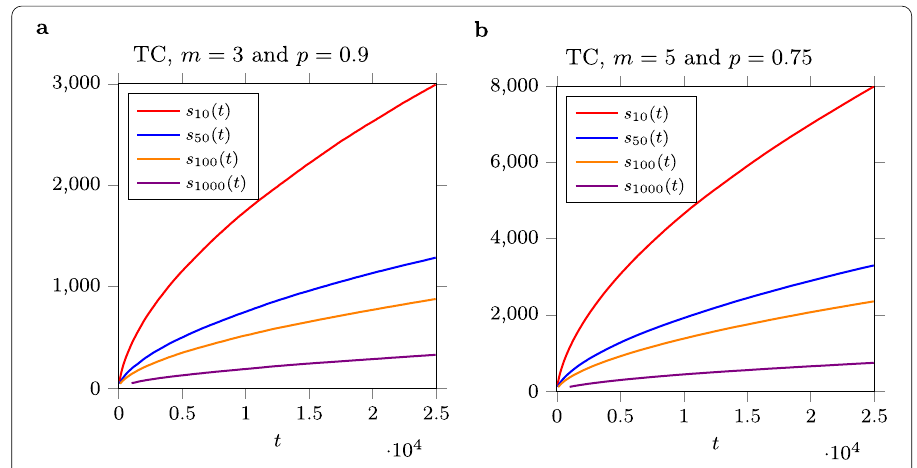
Fig. 13 Evolution of s i in networks based on triadic closure for selected nodes v i , i = 10,50,100,1000 , as t iterates up to 25000. Network in the figure a is modeled with m = 3 , p = 0.9 , while b is simulated with m = 5 , p =